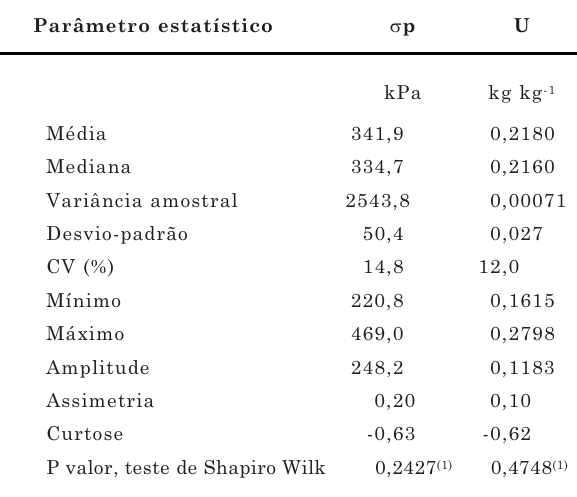
conforme o erro p